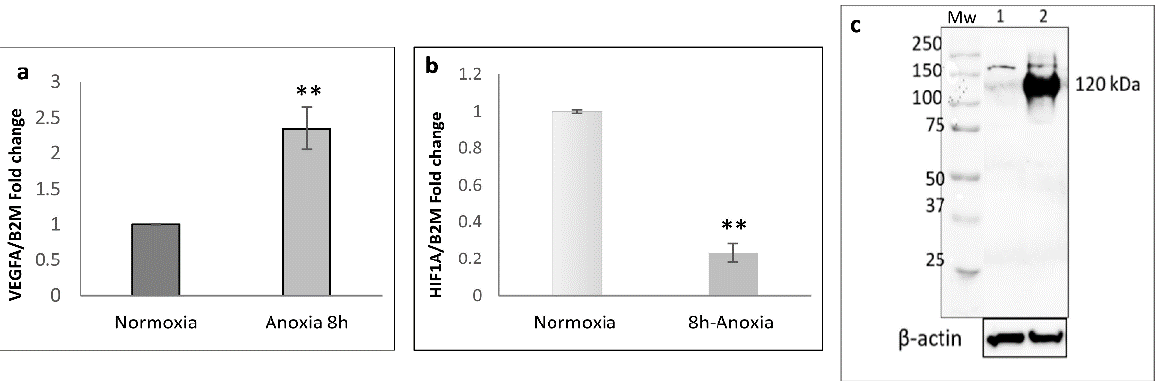
Figure 2. Analysis of mRNA levels of VEGFA ( a ) and HIF1A ( b ). Values are expressed as mean ± SD; n = 2, ** p < 0.01 when compared with normoxic cells. ( c ) Immunoblotting analysis of HIF-1α protein in same cell extracts of HUVEC exposed to 8 h anoxia. 20 µg of total extract protein were loaded in each lane (lane 1; normoxia; lane 2; 8 h anoxia). β-actin was detected as protein loading control.